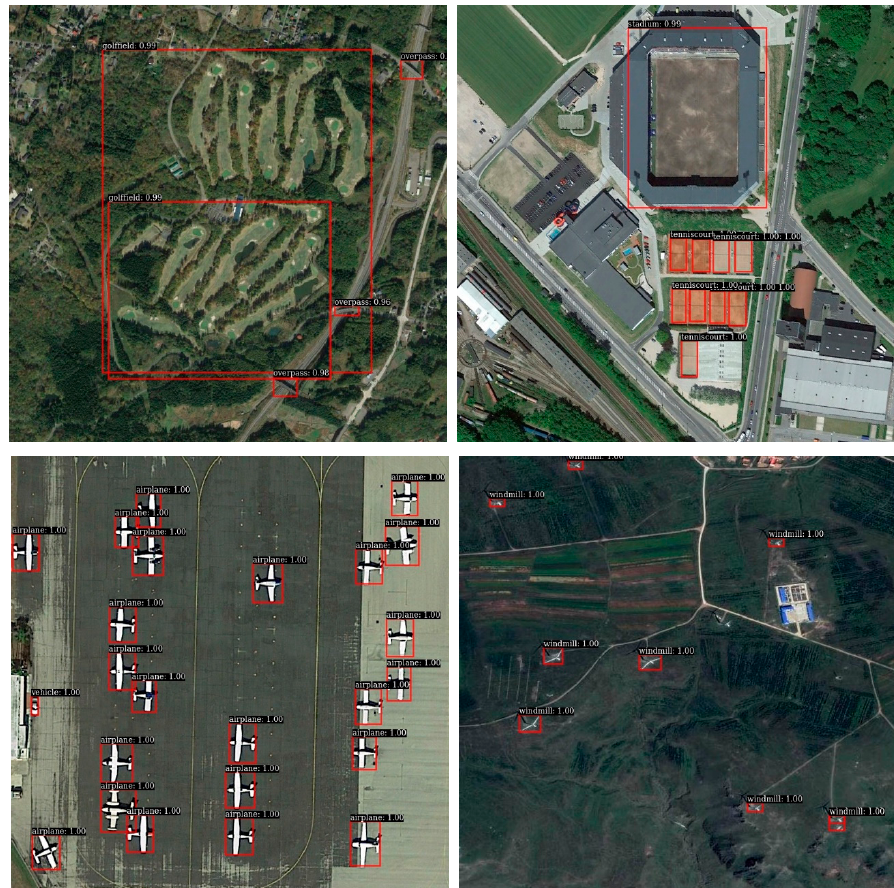
Figure 10. Subjective evaluations on 10 testing images from the DIOR dataset.